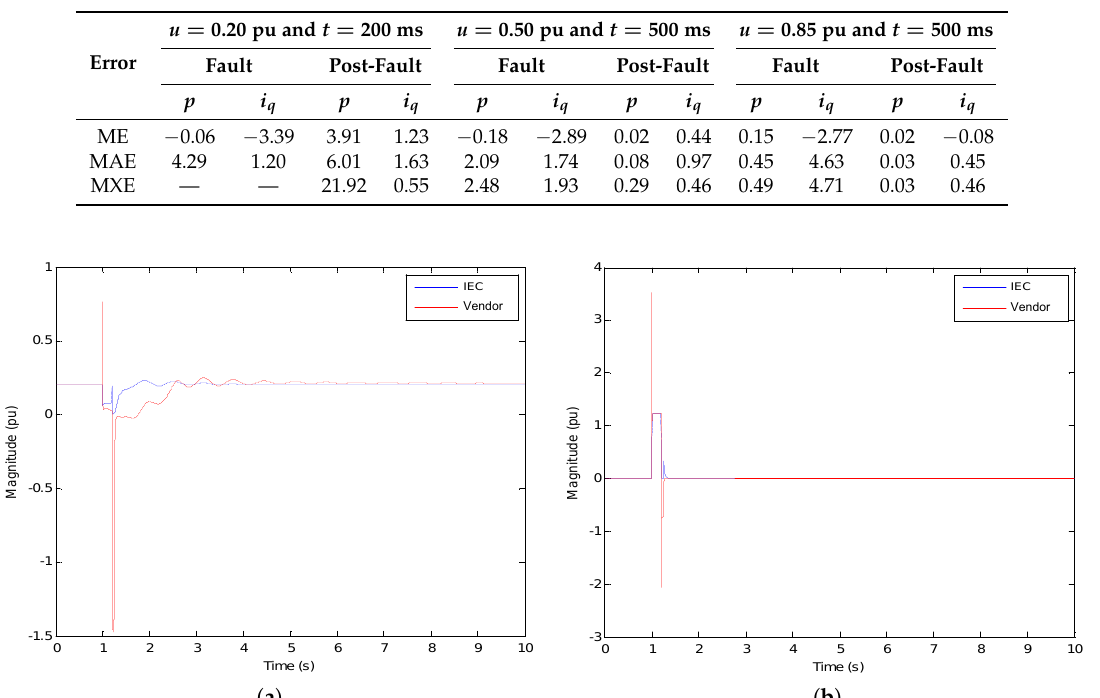
Table 1. Validation results for the Type IIIB wind turbine, in %. Partial load simulation scenario: p = 0.20 pu. ME: mean error; MAE: mean absolute error; and MXE: maximum absolute error.